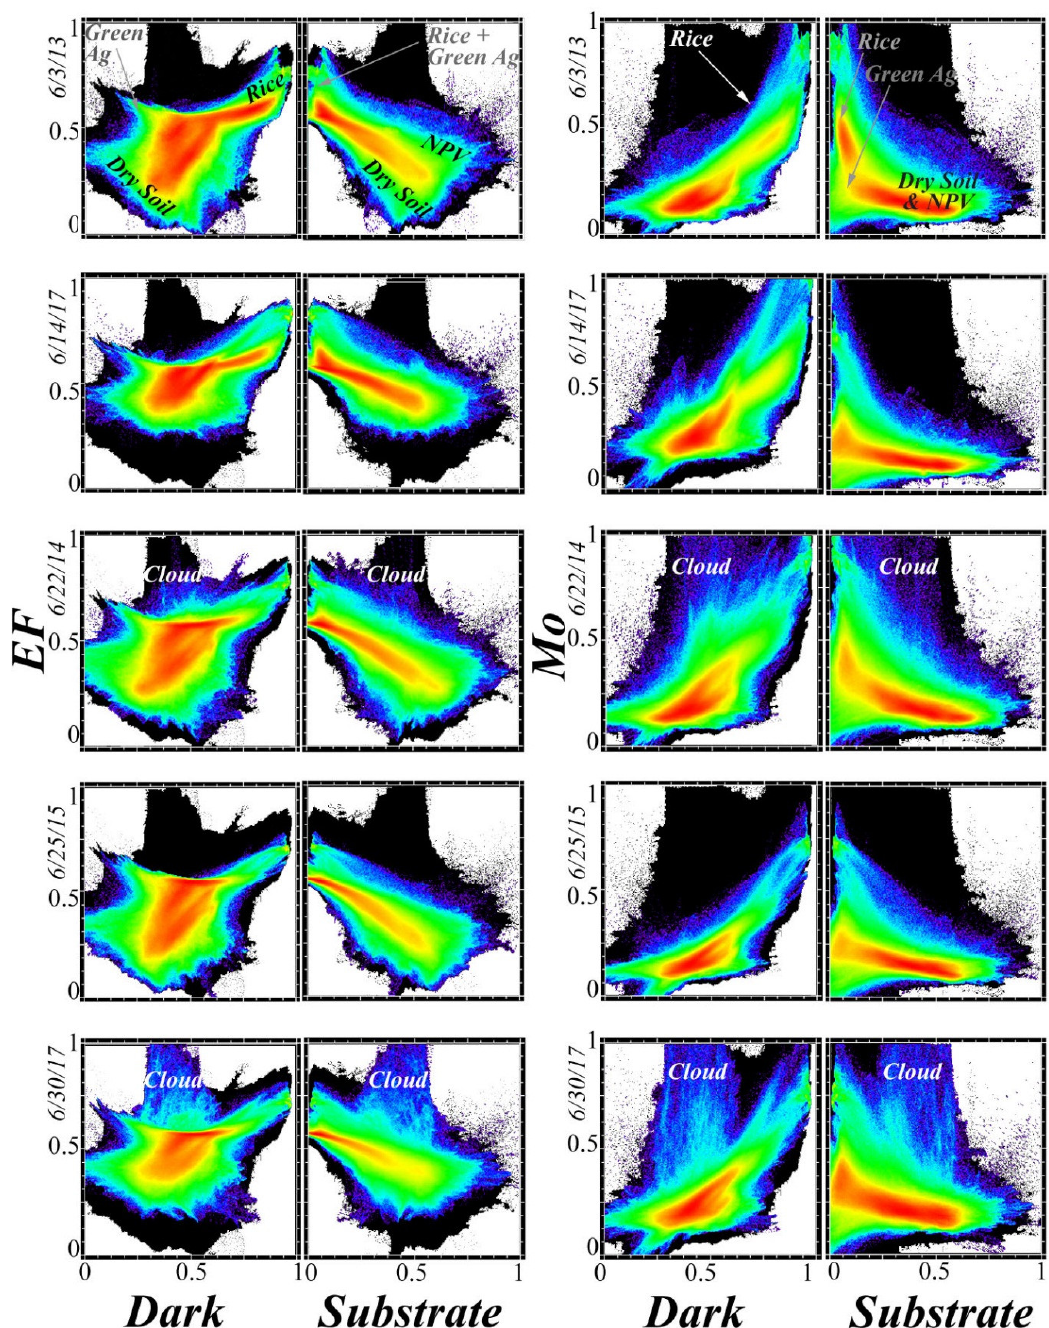
Figure 4. Dark and Substrate Fractions vs EF and Mo. Corresponding α vs EF and Mo spaces are not shown because nearly indistinguishable from the mirror image of the D vs EF and Mo spaces. The rice paddy cluster is present in both D vs EF and D vs Mo spaces, but only weakly in S vs Mo. High EF values are partitioned between green (non-rice) agriculture at low D & low S values and rice paddies at high D and low S values. D vs Mo distributions generally show increasing Mo with increasing D. S vs EF and MO distributions show decreasing EF and MO with increasing S.